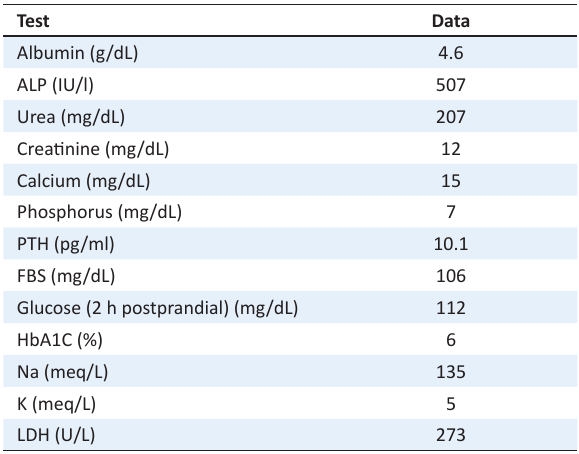
Table 2 . Blood chemistry and hormones of the patient with multiple myeloma and acute renal failure